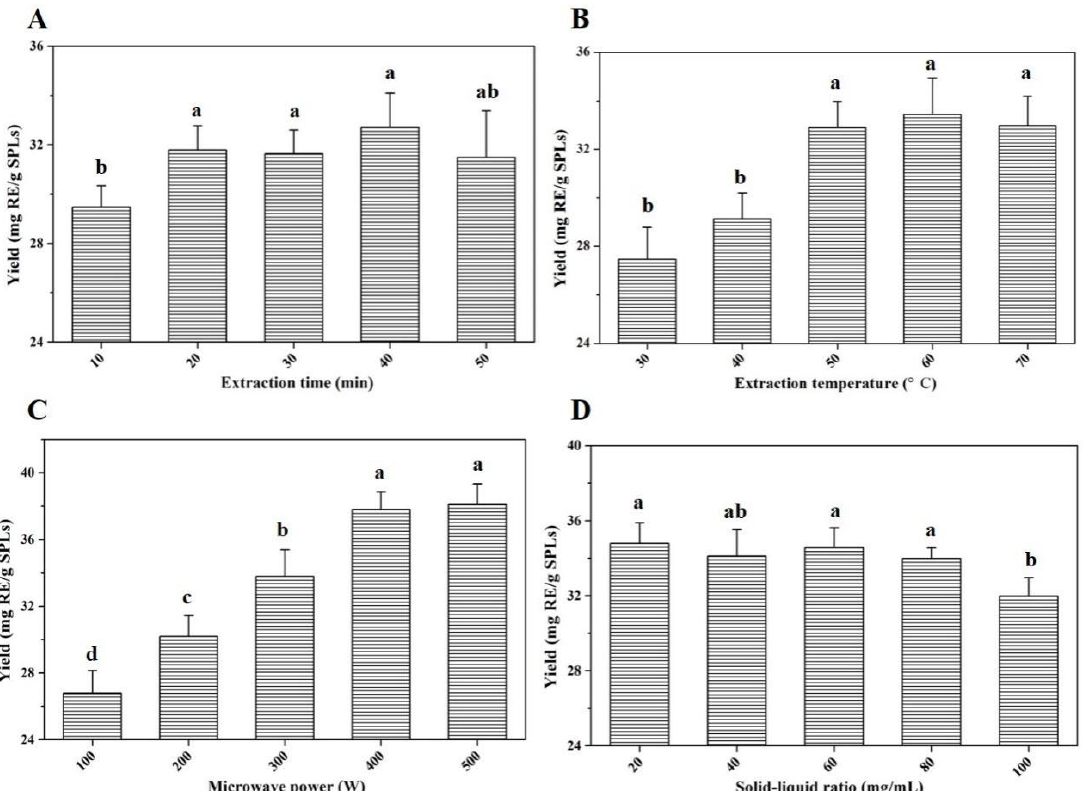
Figure 2. Extraction yields of total flavonoid compounds from SPLs with different influencing factors. Invariant extraction conditions: 200 W, 50 °C, and 100 mg/mL ( A ); 200 W, 20 min, and 100 mg/mL ( B ); 20 min, 50 °C, and 100 mg/mL ( C ); 200 W, 20 min, and 50 °C ( D ). Data sharing different letters were significantly different ( p < 0.05). Table 5. ANOVA of the regression model for extraction yield.